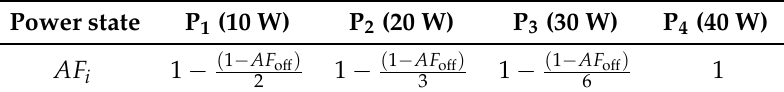
Table 1. AF i values for each power state — linear